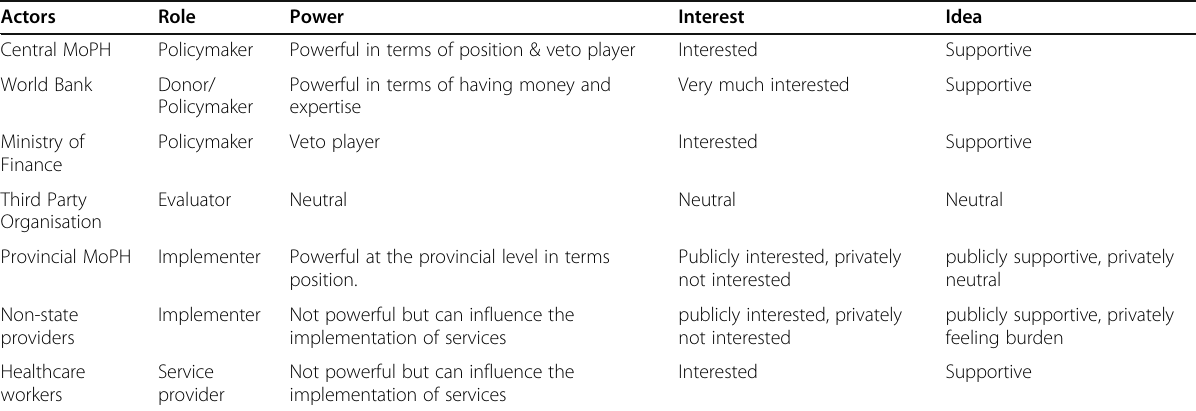
Table 3 PBF programme actor matrix